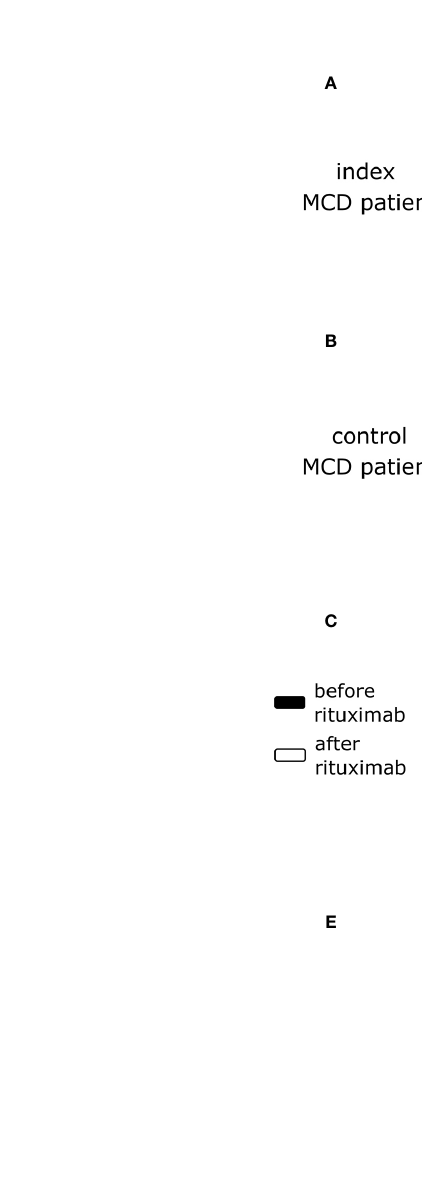
FIGURE 4 | RTX-AF647 + CD3 + T cells of the index MCD patient (A) and the control MCD patient (B) before (left panel) and after (right panel) rituximab treatment. (C) Frequency of CD3 + T cells as percentage of lymphocytes and (D) frequency of RTX-AF647 + cells among CD3 + T cells, (E) CD4 + T cells, and (F) CD8 + T cells before (black) and after (white) rituximab treatment in the index MCD patient and the control MCD